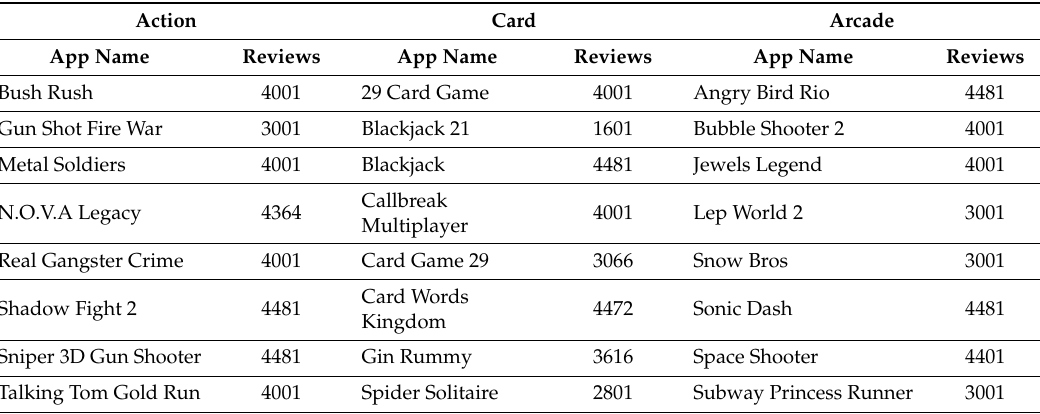
Figure 1. Methodology diagram of data collection and sample shot of dataset. Table 1. Detail measurements of scraped datasets .